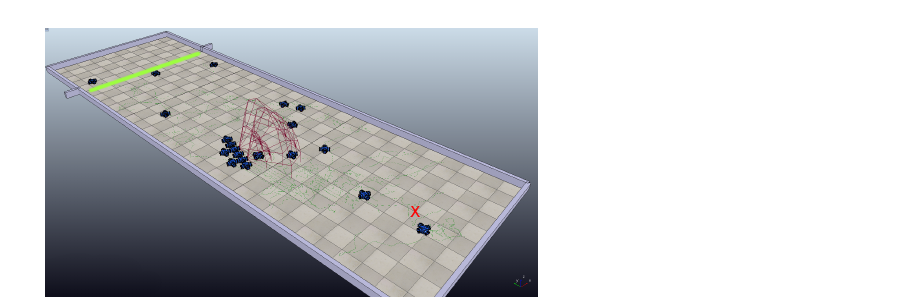
Figure 7. A screenshot from a simulation using the MLR strategy. Note the scattering of robots throughout the space as the forming organism drives towards the finishing line, marked in green. The location where the seed initially starts is marked with a cross. The larger red wireframe shapes represent IR communication ranges on the highest power setting; the smaller ones show docking- guidance signal ranges.